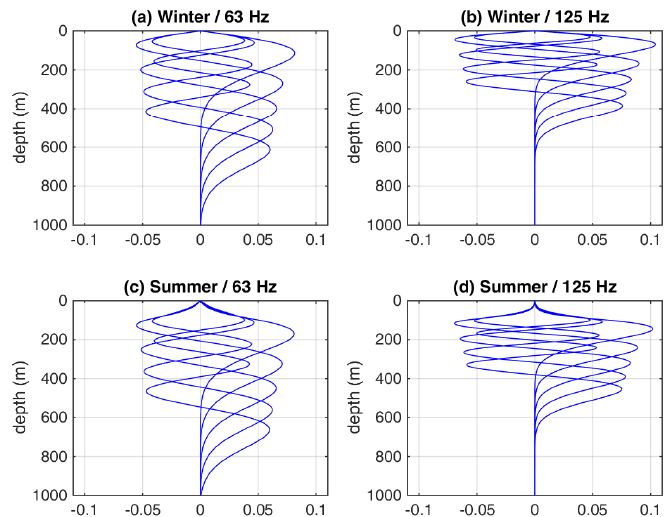
Figure 5. Depth dependence of the first 5 modes for the winter SVP at ( a ) 63 Hz and ( b ) 125 Hz, as well as for the summer SVP at ( c ) 63 Hz and ( d ) 125 Hz.